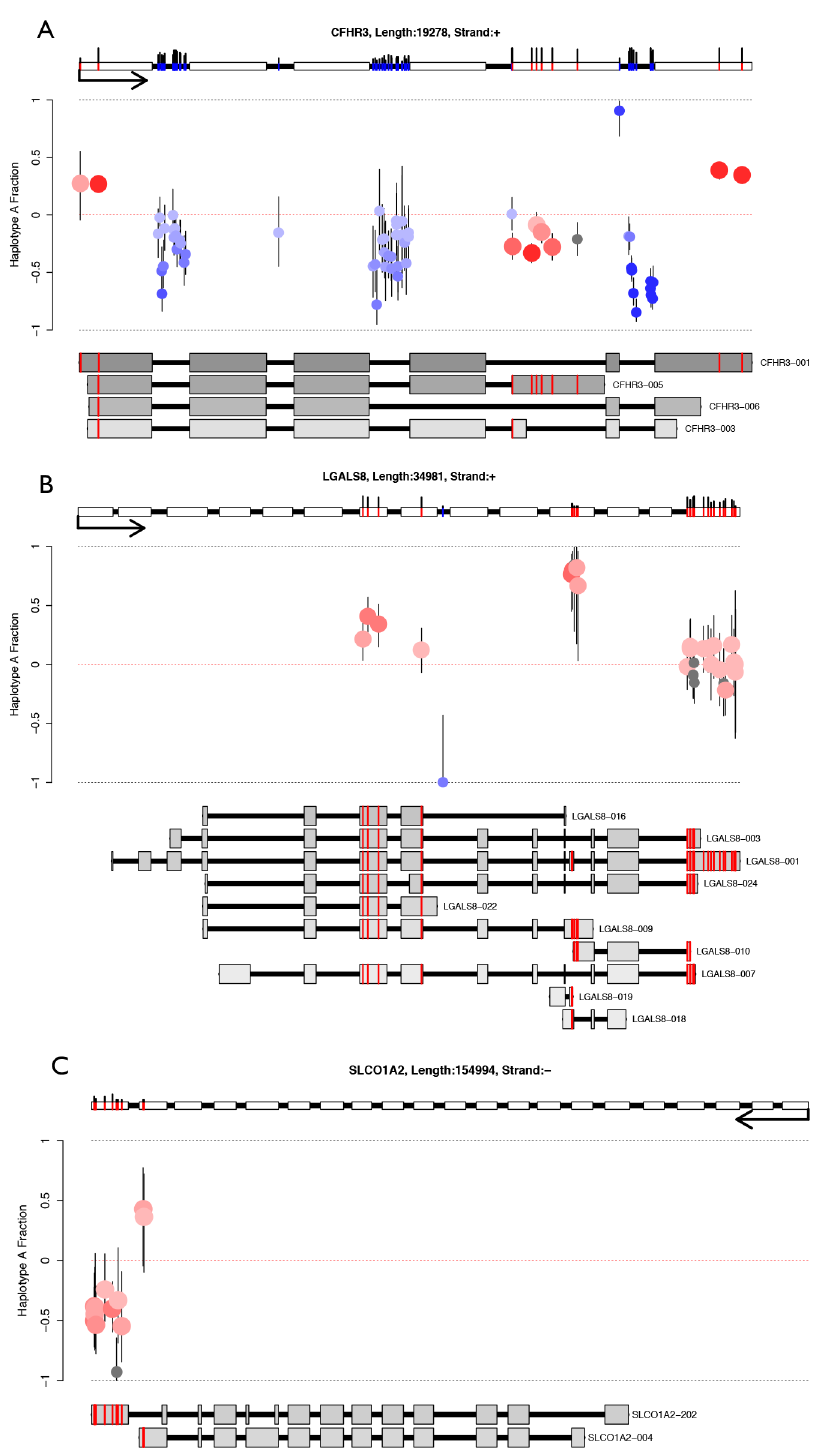
Fig 8. Putative allele-specific isoform expression. Red circles are exonic SNPs, blue circles intronic SNPs, gray circles are filtered SNPs (either poor alignability or SNV proximity). SNP colour is proportional to probability of ASE (darker is more significant). Error bars represent the 95% binomial confidence interval (Pearson-Klopper). The gene model at the top shows the exonic (red) and intronic (blue) SNPs, the black sticks above these represent the read depth (min height represents 10 reads, max height 200 or more